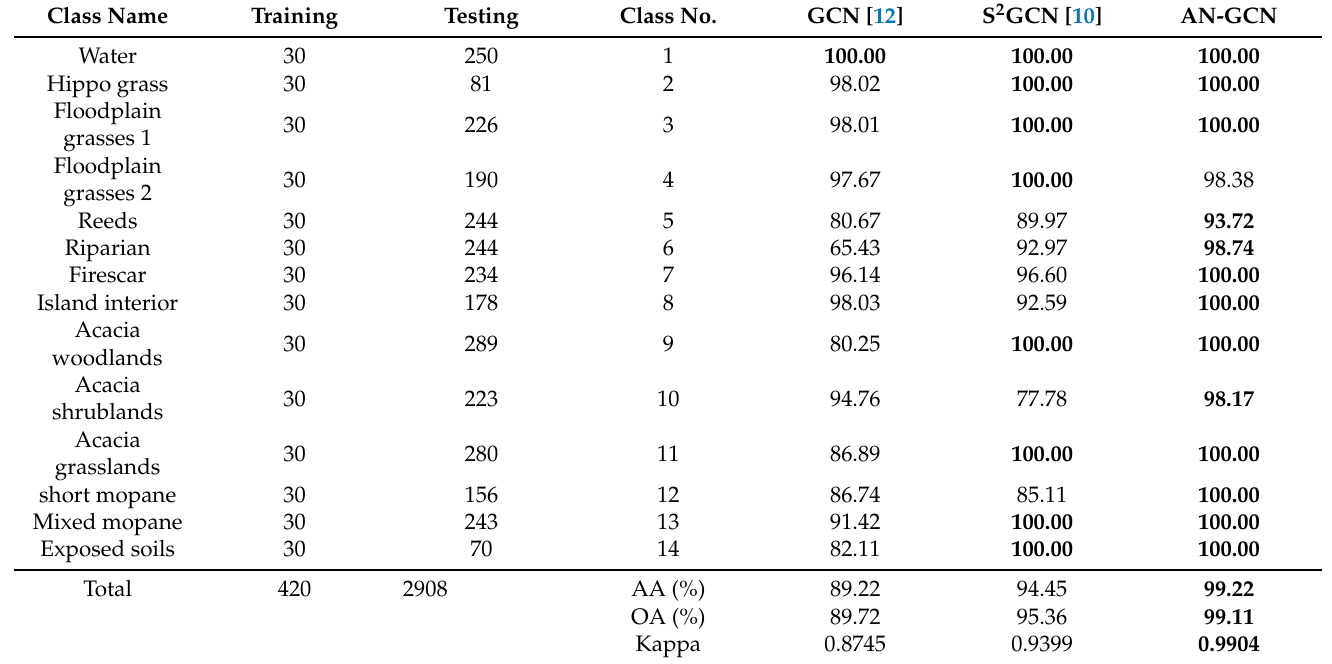
Table 9. Number of training and testing samples for the different classes and classification perfor- mance (%) of various GCN methods for Botswana dataset.